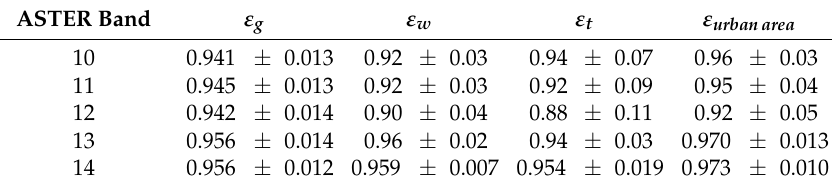
Table 6. Emissivity of urban areas ( ε urban area ) used by the VCM algorithm for the ASTER TIR bands. The values of the emissivities and uncertainties of building tops ( ε t ), streets ( ε g ) and building walls ( ε w ) used to retrieve the emissivity of urban areas are also shown. See the main text for additional details. ASTER Band ε g ε w ε t ε urbanarea